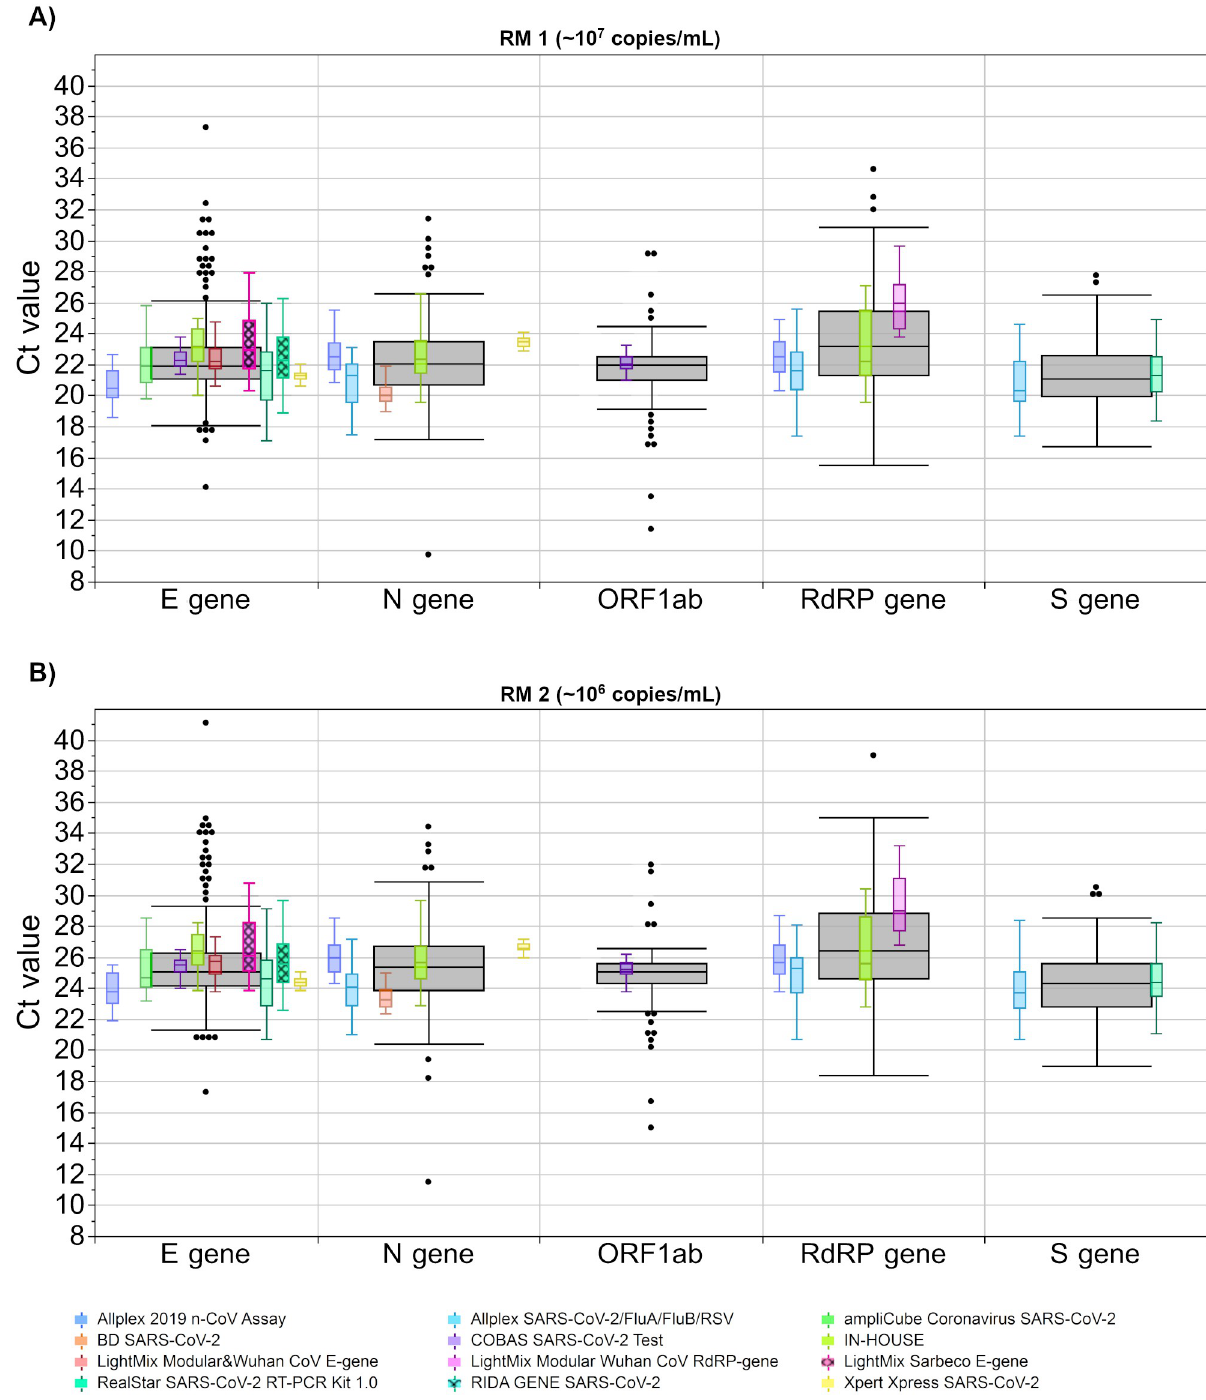
Fig 6. Analysis of Ct values for both samples for different test systems. The concentration of RM 1 (A) is estimated with at 10 7 copies/mL and the concentration of RM 2 (B) is estimated with at 10 6 copies/mL. The black boxes display all results for the respective sample, and the distributions of specific manufacturer-based collectives are illustrated as smaller, colored box plots in overlay with the total results. Outlier were excluded from colored boxes. Collectives are shown for eleven test kits. For all boxes, the whiskers stretch from the 1st quartile—1.5 � (interquartile range) to the 3rd quartile + 1.5 � (interquartile